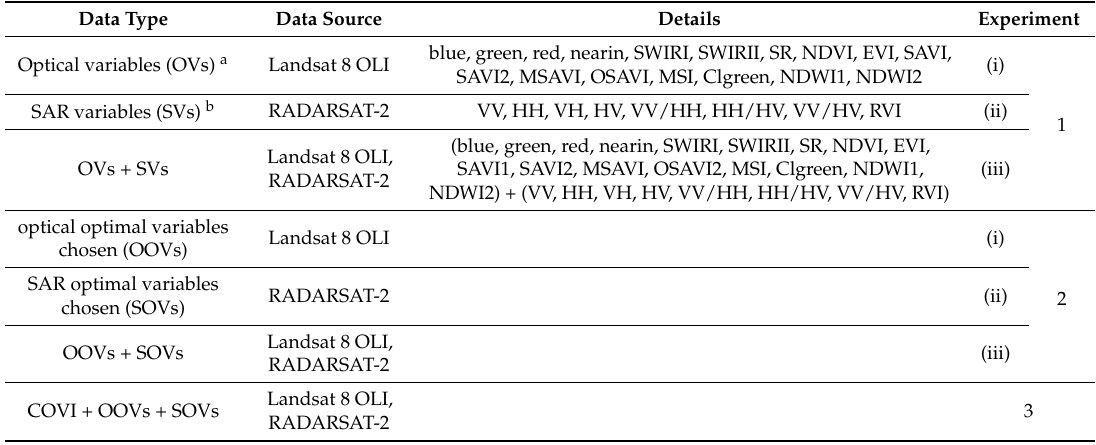
Table 1. Landsat 8 OLI and RADARSAT-2 predictor variables used in forest AGB